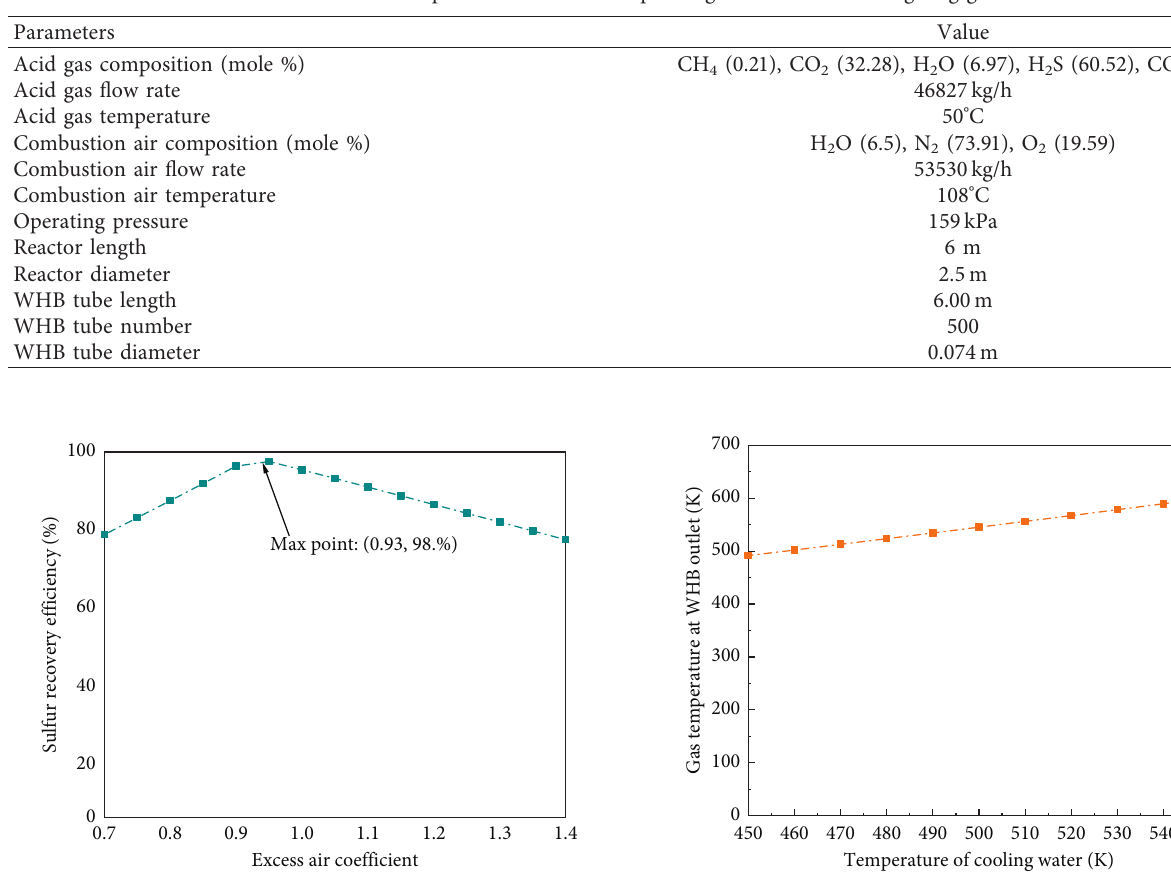
Figure 9: Sulfur recovery efficiency as a function of the excess air